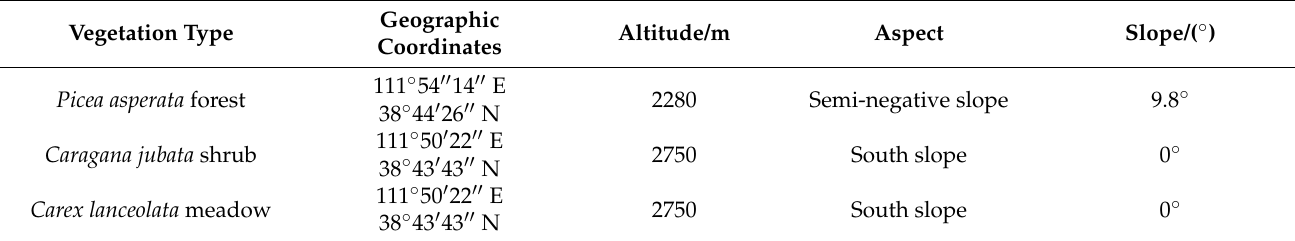
Table 1. The sampling sites information in Luya